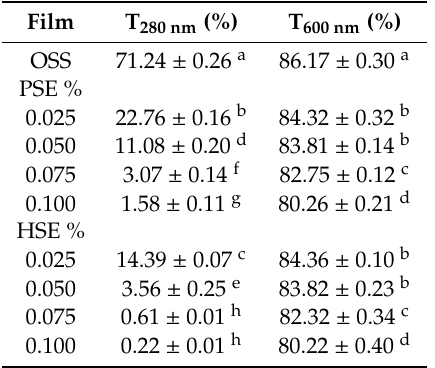
Table 5. UV-light and visible-light transparency of octenyl succinate starch